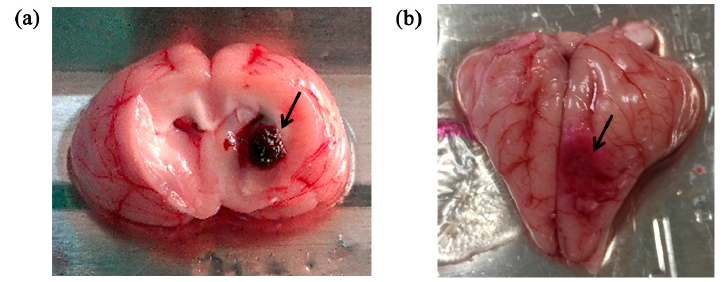
Figure 3. ( a ) The intracerebral hemorrhage model; ( b ) The ischemic model. The black arrow indicates